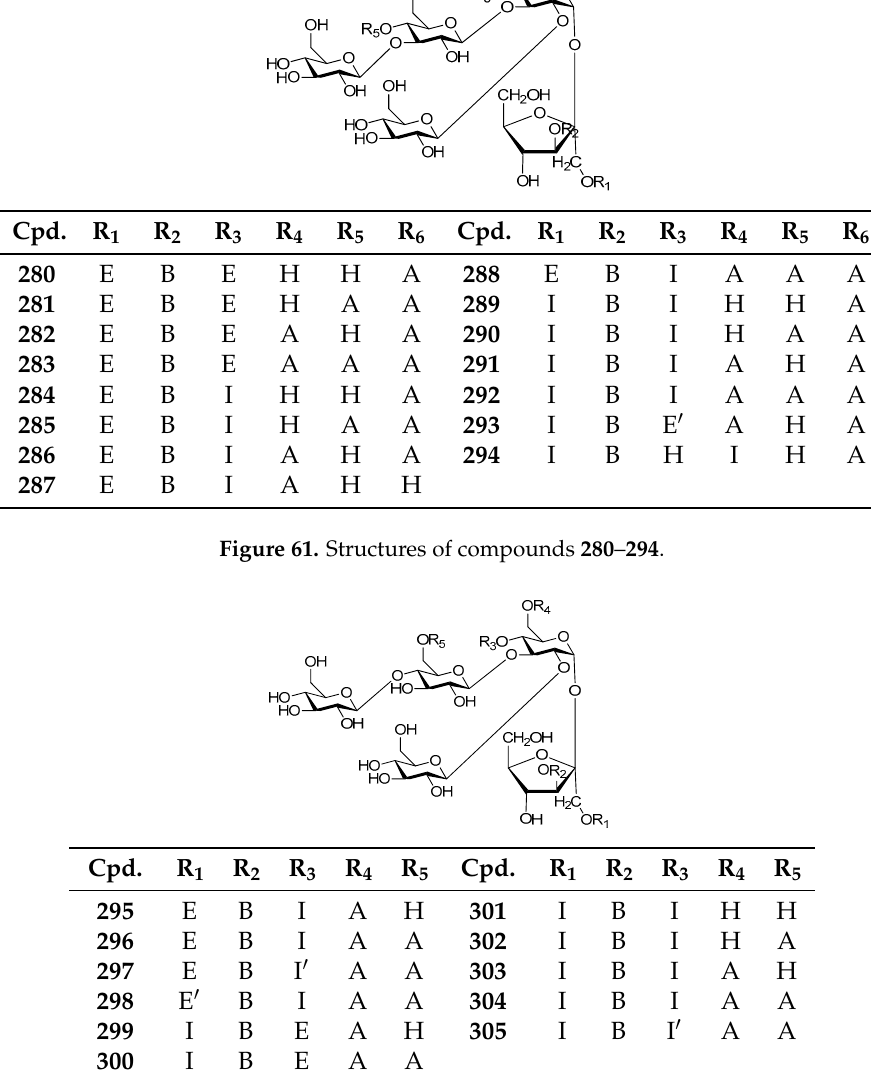
Figure 62. Structures of compounds 295 – 305 .